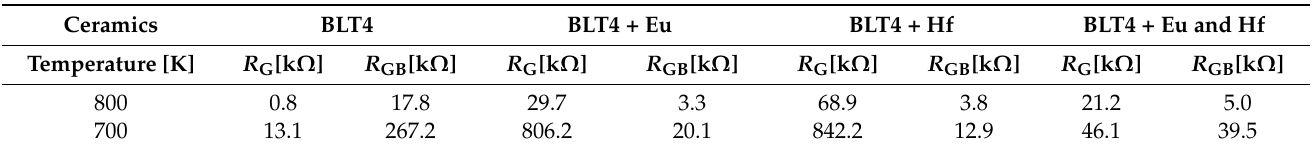
Figure 12. Dependence of the natural logarithm of the grains resistivity ( R G ) ( a ) and grain bound- aries resistivity ( R GB ) ( b ) values calculated on the basis of impedance spectra as a function of the temperature inverse of pure and modified BLT4 ceramics. Table 6. Values of grain resistivity R G and grain-boundary resistivity R GB of undoped and modified BLT4, obtained at the three exemplary temperatures.